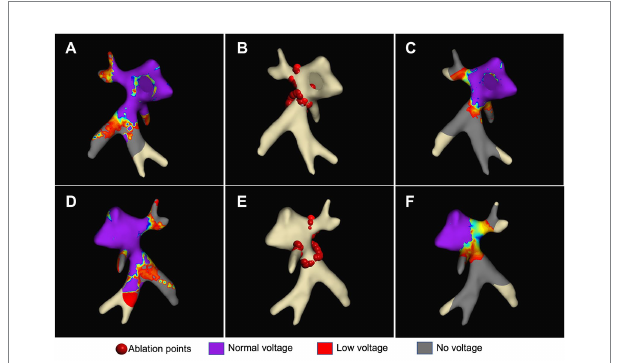
FIGURE 6 Pulmonary vein isolation. Left atrial maps in anterior–posterior (A–C) and posterior–anterior (D–F) projection. Voltage maps before (A, D) and after (C, F) selective circumferential pulmonary vein isolation points (red dots) (B + E: lesion set) with purple indication normal voltage (> 0.5 mV), blue to red indicating low voltage (0.1–0.5 mV) and grey indicating no voltage (<0.1